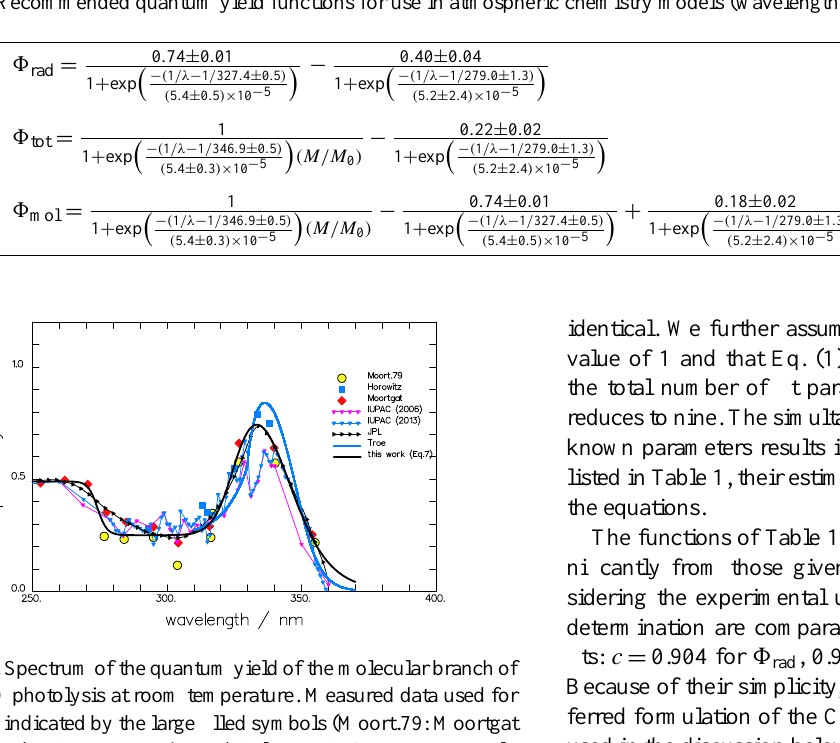
Table 1. Recommended quantum yield functions for use in atmospheric chemistry models (wavelength λ in nm).